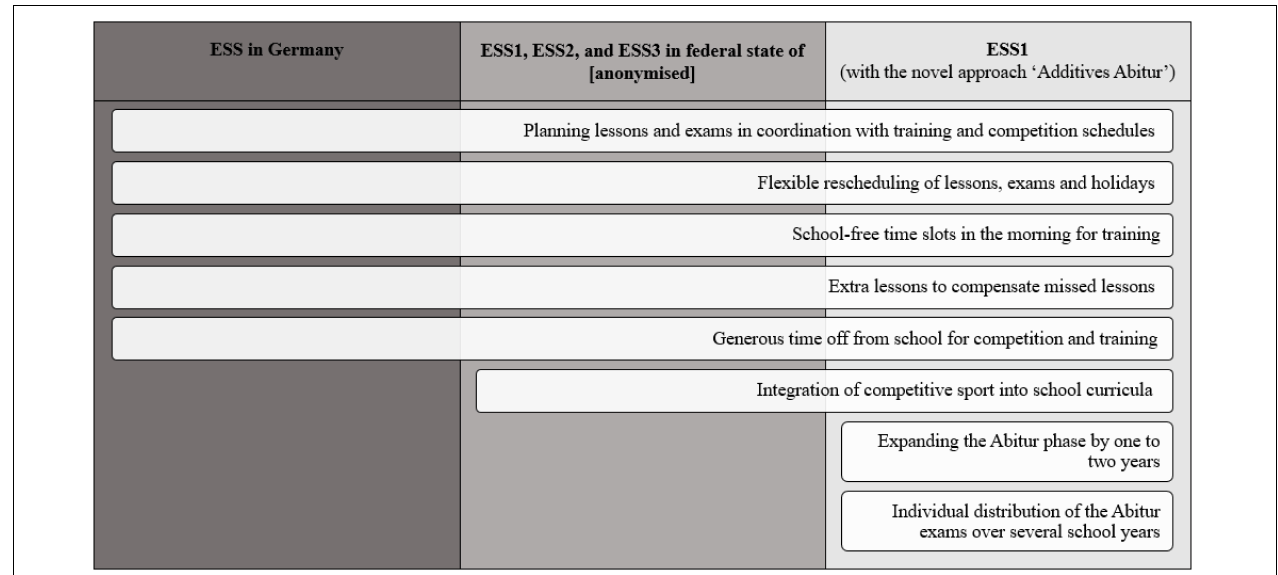
FIGURE 1 | Dual career support services at Elite Sport Schools (ESSs) for student-athletes in Germany, the federal state of Brandenburg, and the ESS1. ESS1, Elite Sport School in the federal state of Brandenburg where the dual career support service “Additives Abitur” was tested.